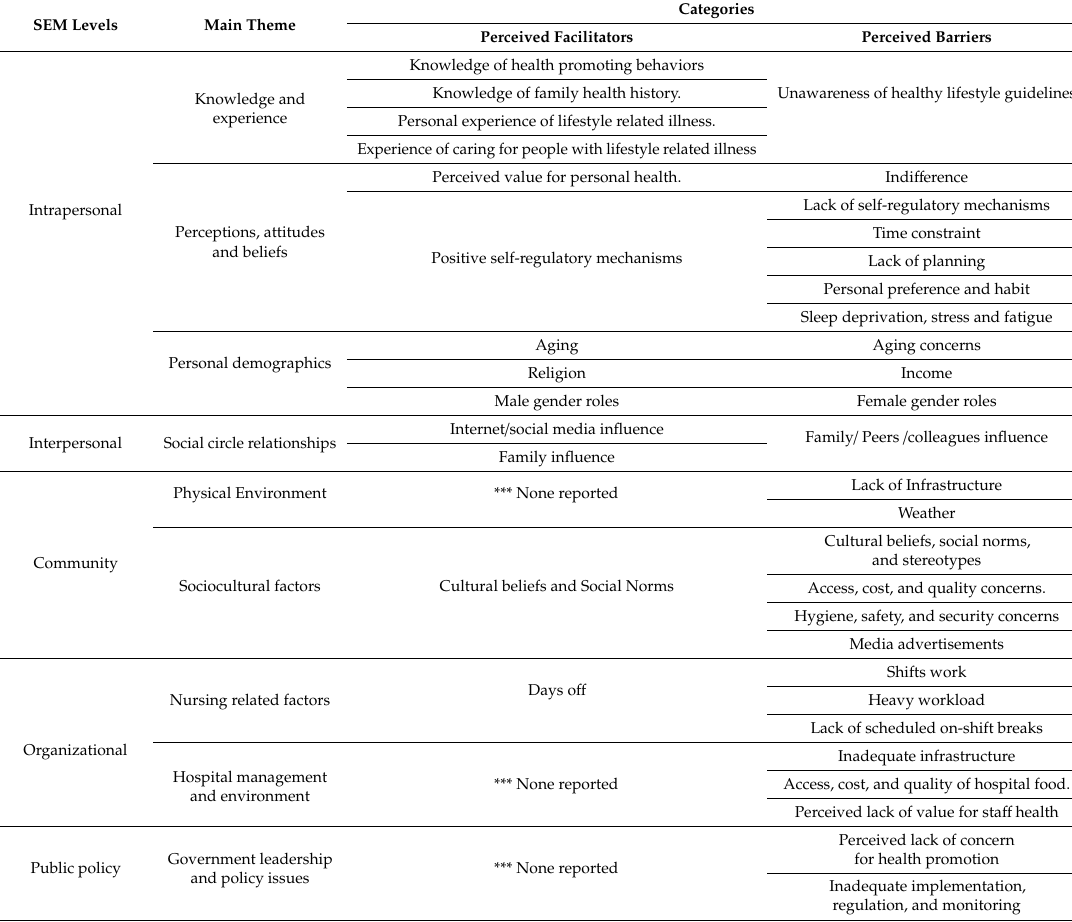
Table 2. Themes for facilitators and barriers to Nigeria nurses’ engagement in health promoting behaviors (HPBs) mapped onto the five levels of the socio-ecological model